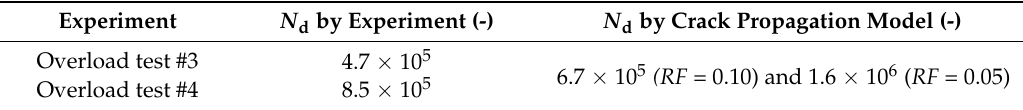
Table 5. Delay cycles N d by experiment and model for overload tests with R OL = 2.5.